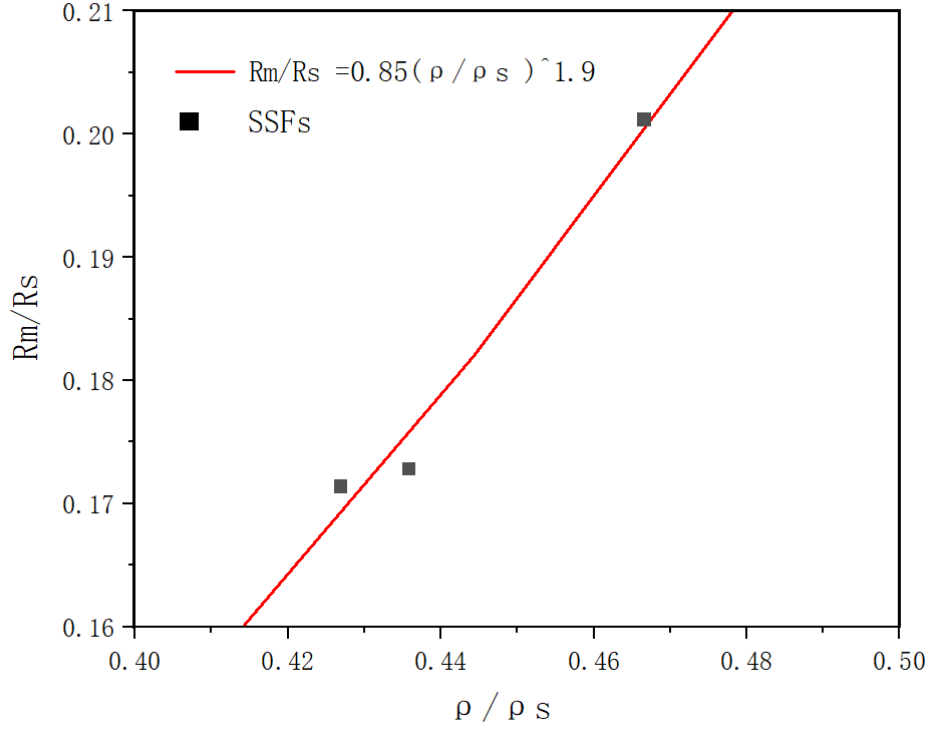
Figure 7. The plot of Equation (2) and the correlation factor of the